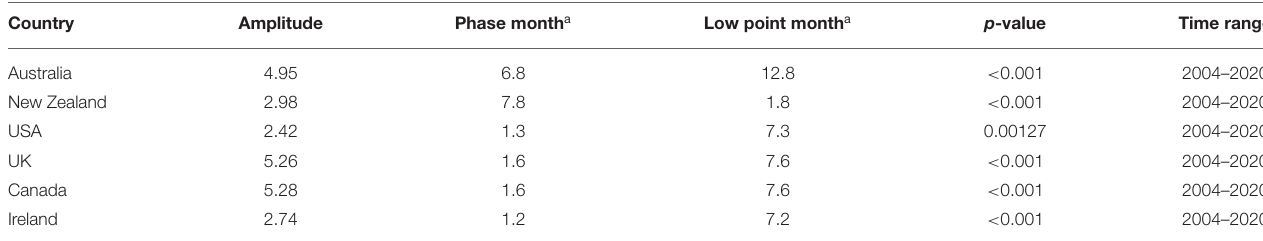
TABLE 2 | The seasonal variation in the Alzheimer’s disease-related relative search volumes.